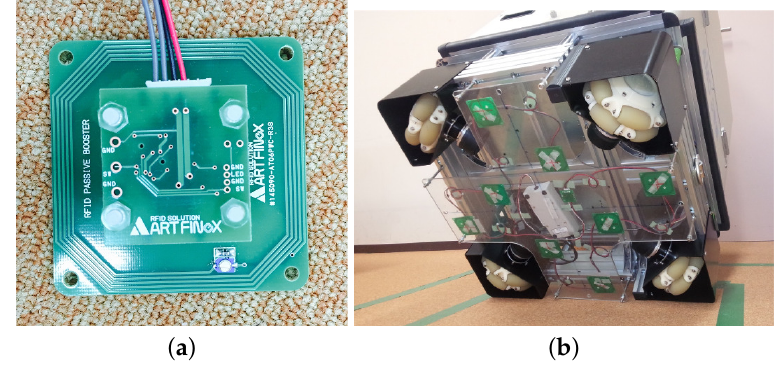
Figure 12. Installation of eight HF-band RFID readers at the bottom of an omni-directional vehicle. ( a ) An RFID reader; ( b ) bottom view.